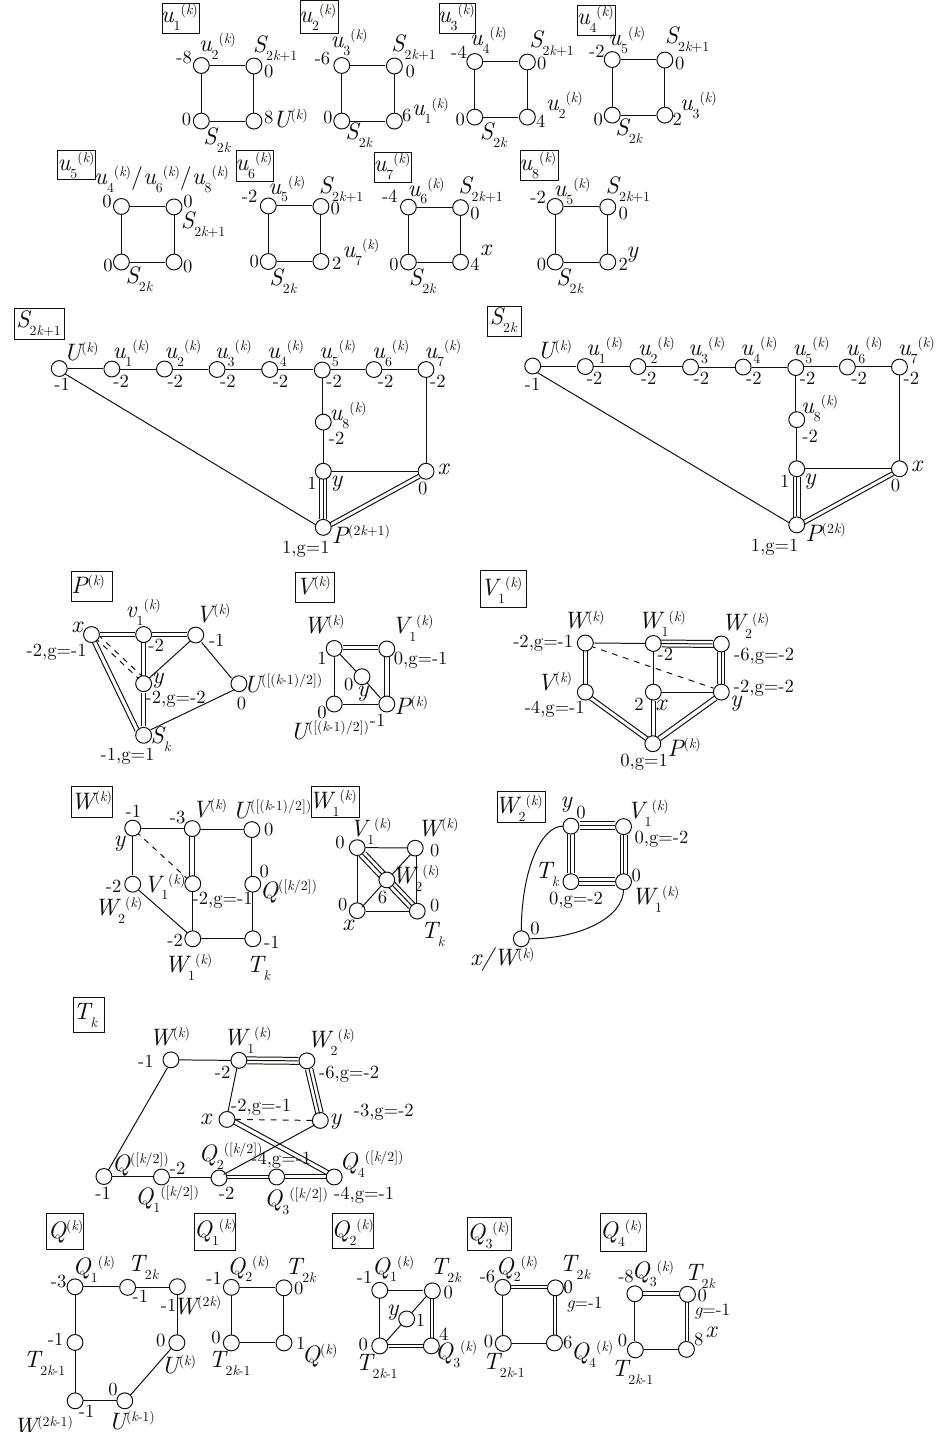
Figure 14. The con(cid:12)guration of curves in the (cid:13)opped geometry of non-minimal ( E 8 ; E 8 ) conformal matter with order N . \[]" means the rounded up integer value. Dotted line means negative intersection number.